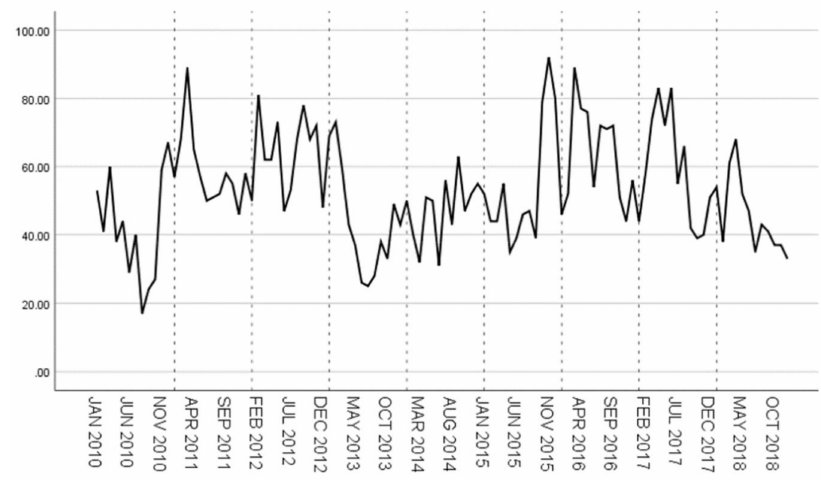
Figure 11. Original time series of hepatitis E from 2010 to 2018.